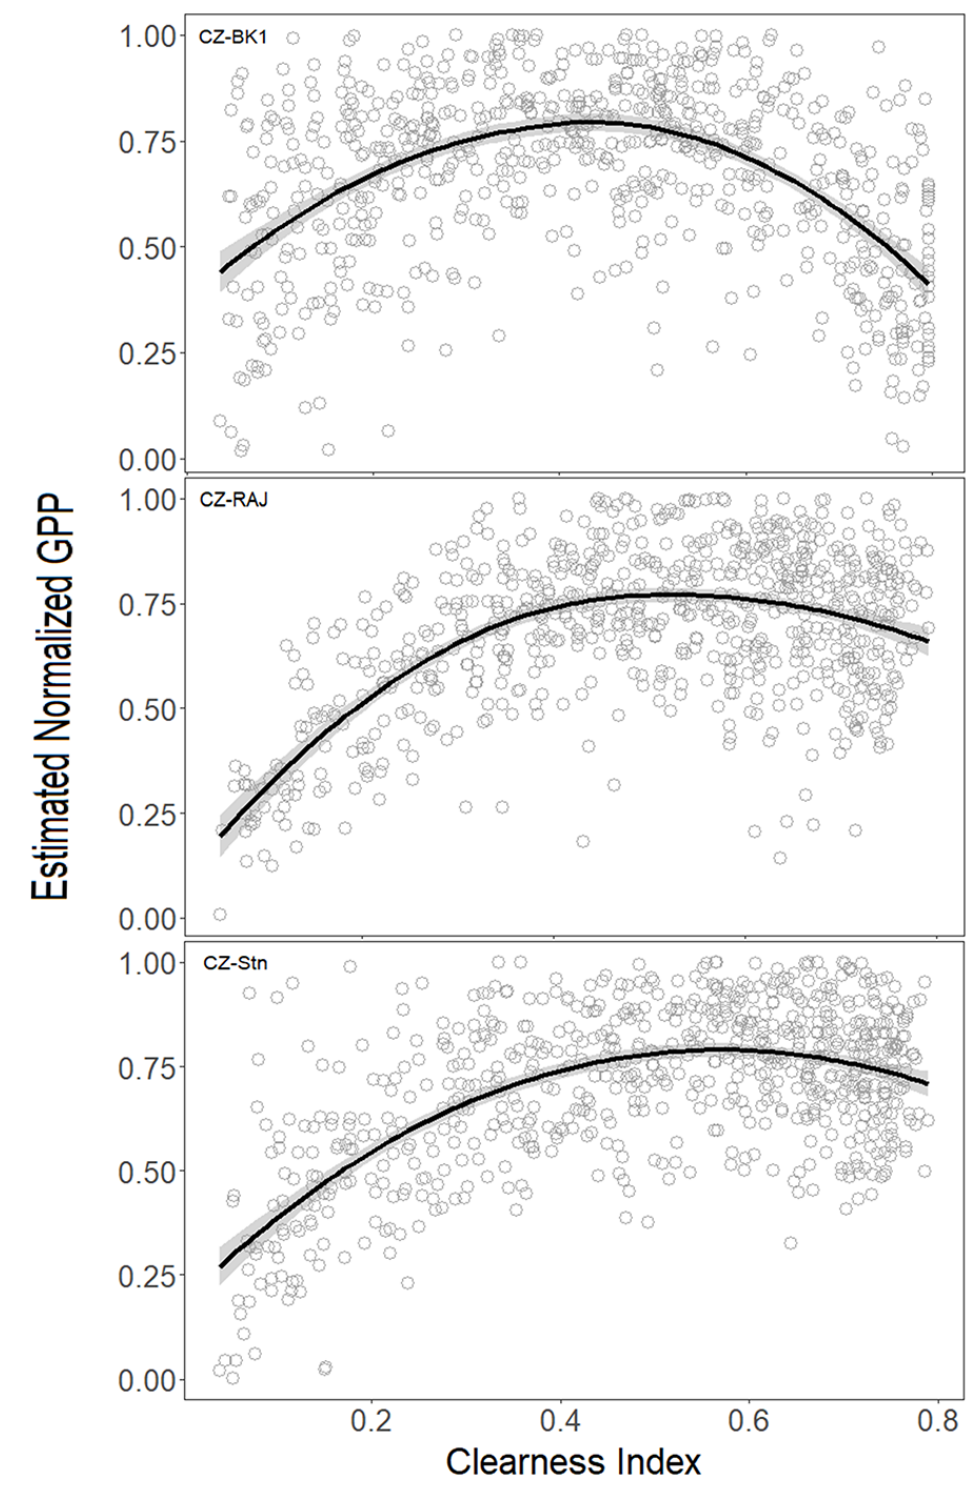
Figure A3. Correlation between the estimated Normalized gross primary productivity (GPP norm ) for May–September of 2012–2016 in the wet spruce forest in Bílý K ˘ rí˘z (CZ-BK1), the dry spruce forest in Rájec (CZ-RAJ) and the beech forest in Štítná (CZ-Stn)